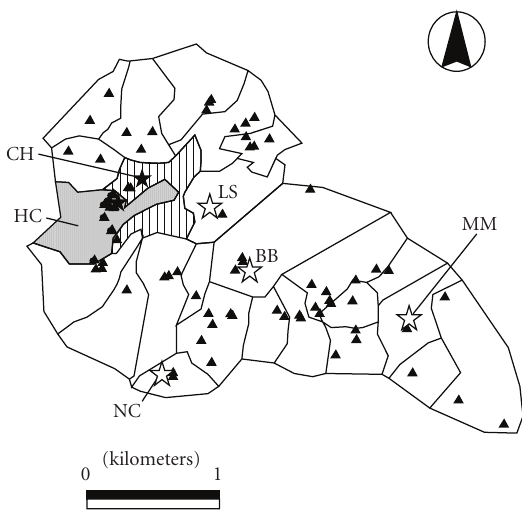
Figure 1: Sett locations (triangles), badger group territory bound- aries (solid lines, 2003), and sett thermometer survey locations (white stars) in Wytham, 2003-2004. Logger survey locations (dots) in the Hill Copse group area (grey) and Chalet group area (stripe) with main setts (black